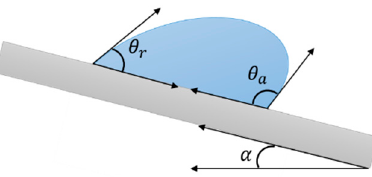
Figure 4. Schematic of advancing and receding angles of a droplet sliding on a surface. Contact angle hysteresis is defined as the difference between these two.